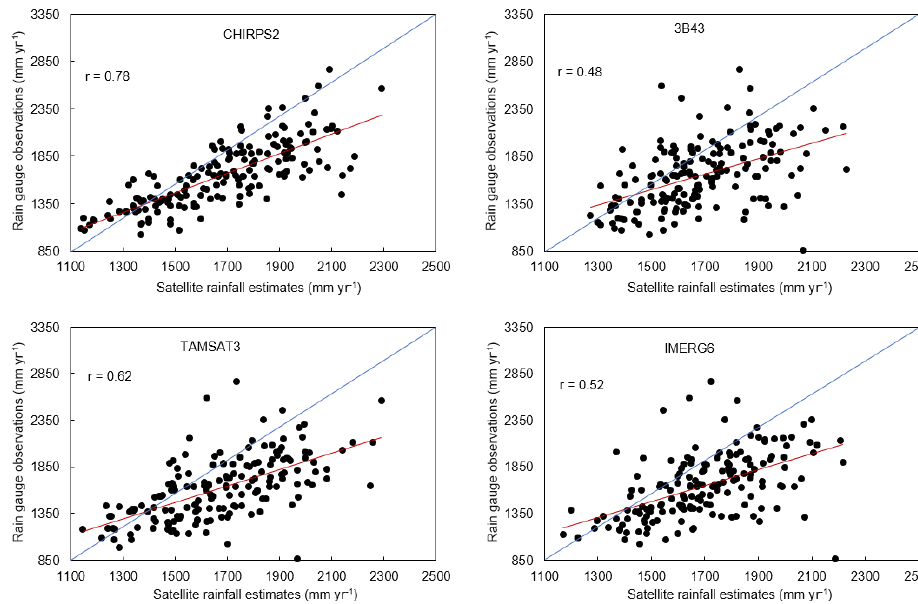
Figure 4. Annual correlation coefficient of the four SREs for the DRB.